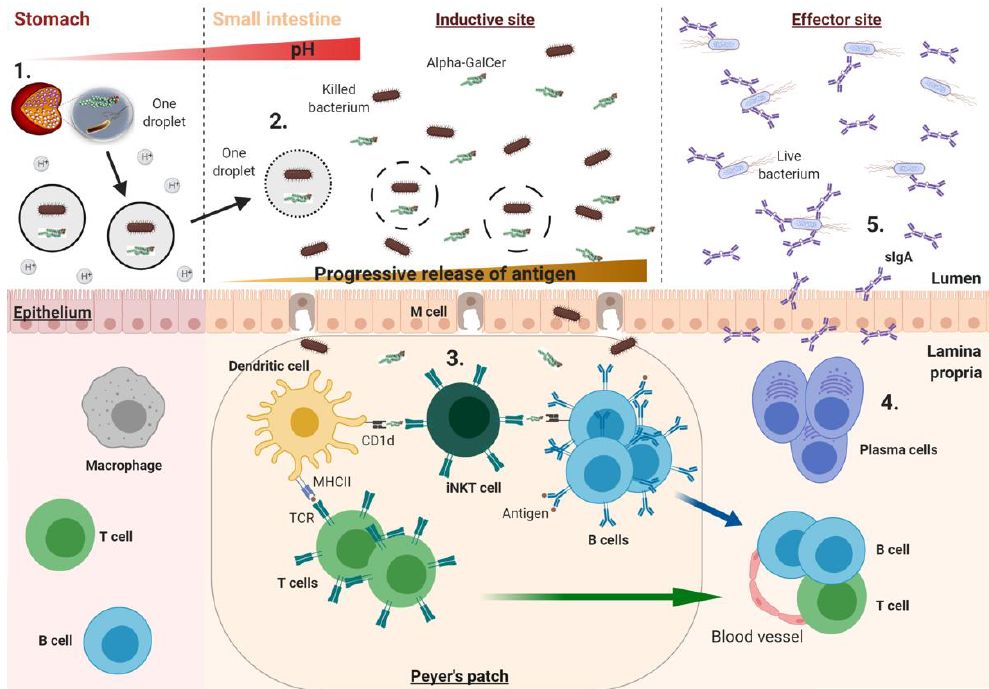
Figure 2. Proposed mechanism of the SmPill ® minispheres and the induction of intestinal vaccine-specific immune responses: 1. The enteric coating of SmPill ® minispheres remains intact in the acidic environment of the stomach protecting the payload; 2. On exiting the stomach and the passage into the increasing pH of the small intestine, the enteric coating begins to degrade, exposing the gelatine core and releasing the oil droplets containing the vaccine antigen (e.g., whole-cell killed bacteria) and the solubilised adjuvant (e.g., α-GalCer); 3. The payload is gradually released in the small intestine and the antigen/adjuvant can cross the intestinal epithelium (e.g., through M cells) where the presentation of processed whole-cell killed bacteria and α-GalCer by DCs to T cells and invariant natural killer T (iNKT) cells occurs, respectively. This leads to B cell activation; 4. B cells undergo affinity maturation, class switch recombination and differentiation into plasma cells, which enter into the circulation and home back to the lamina propria where antigen-specific IgA secretion occurs; 5. Upon infection with viable bacteria, sIgA transported into the intestinal lumen can neutralise the bacteria. Figure prepared using BioRender.